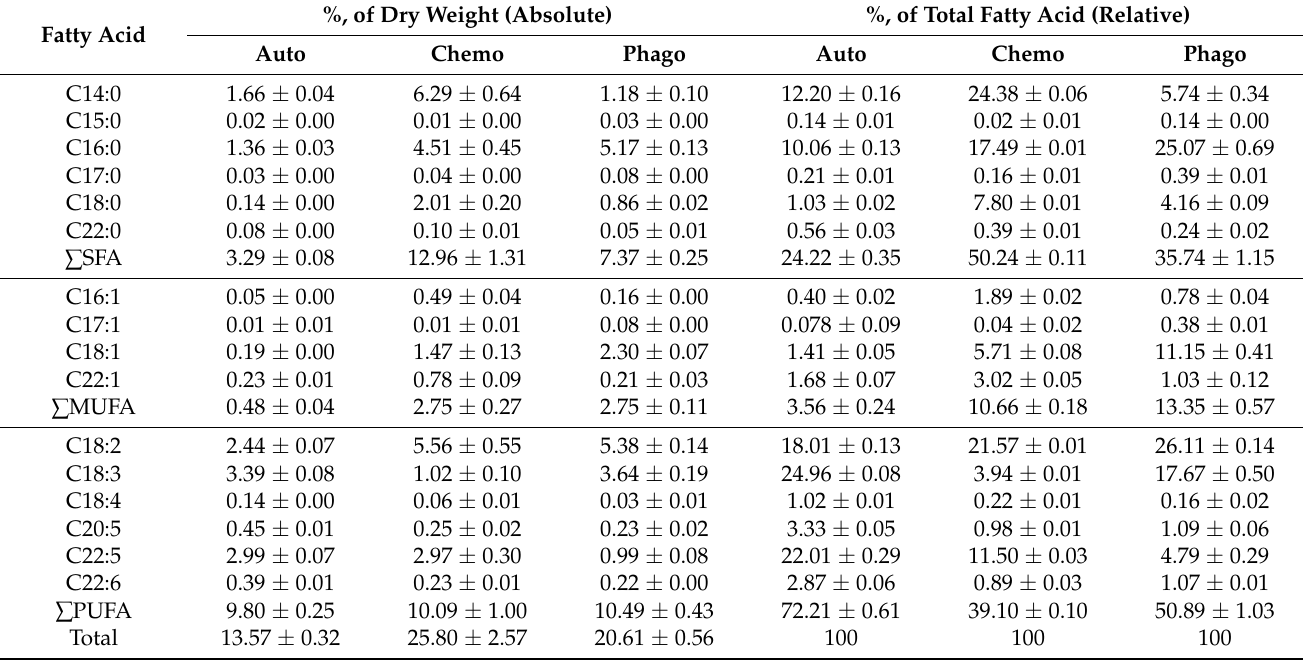
Table 3. Fatty acid composition of P. malhamensis with different nutritional modes ( n = 3).